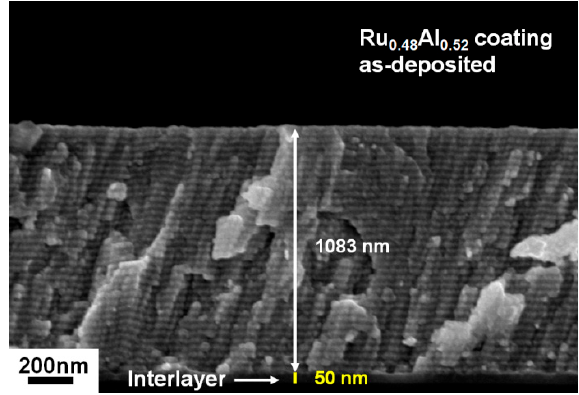
Figure 4. Cross-sectional SEM image of the as-deposited Ru 0.48 Al 0.52 thin films.